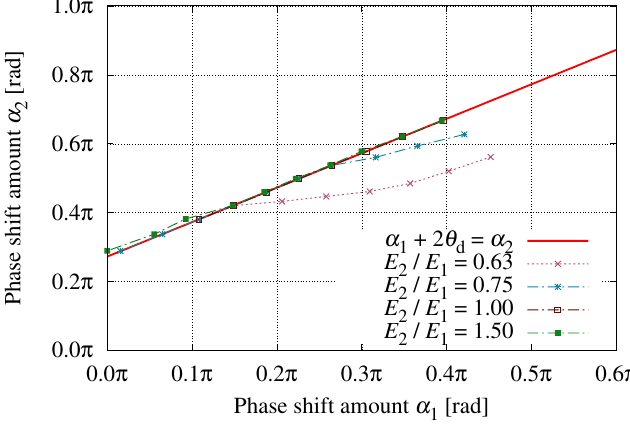
Figure 6. Loci of the maximum efficiency points of the resonant circuit where I charge is varied.